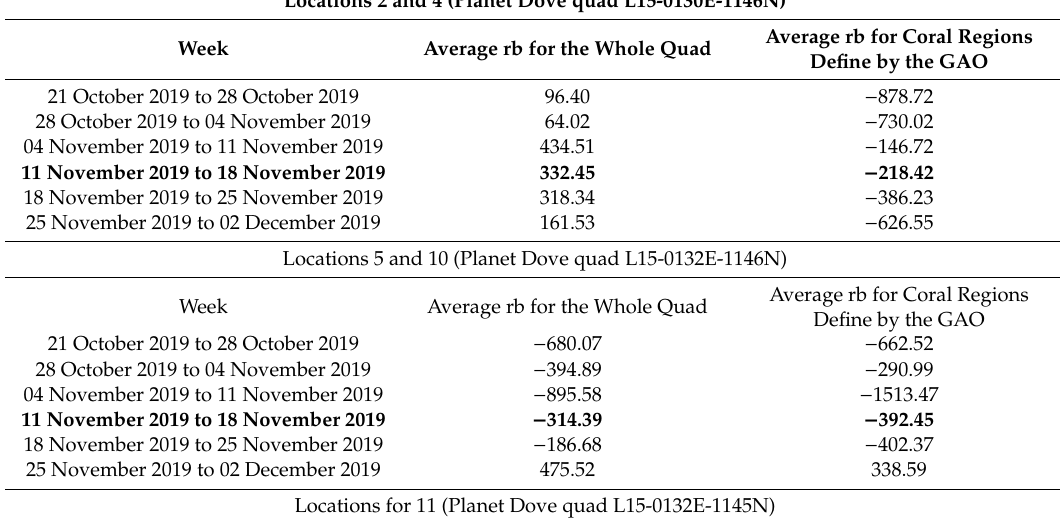
Table A1. Average bottom reflectance for the locations identified in the field. Bottom reflectance values were multiplied by 10,000 to improve readability. Bold rows indicate the field survey week. We calculated the average bottom reflectance (rb) value for the whole quad as well as for the coral regions defined by the Global Airborne Observatory (GAO). Negative rb values show the pixels or the whole quad are dark, indicating low signal-to-noise ratio of bottom